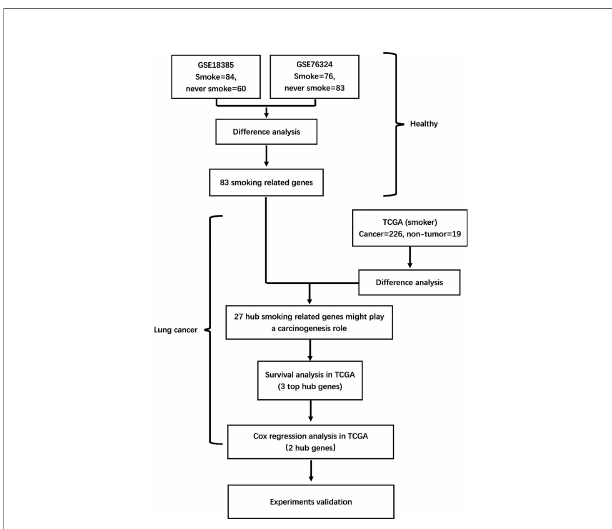
FIGURE 1 | Flowchart of the study. GSE18385 and GSE76324, Gene Expression Omnibus cohorts; TCGA, The Cancer Genome